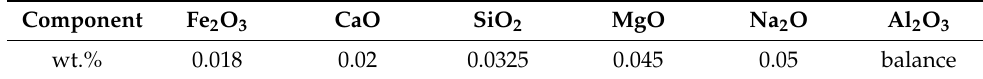
Table 1. Chemical composition of the alumina used in this research.